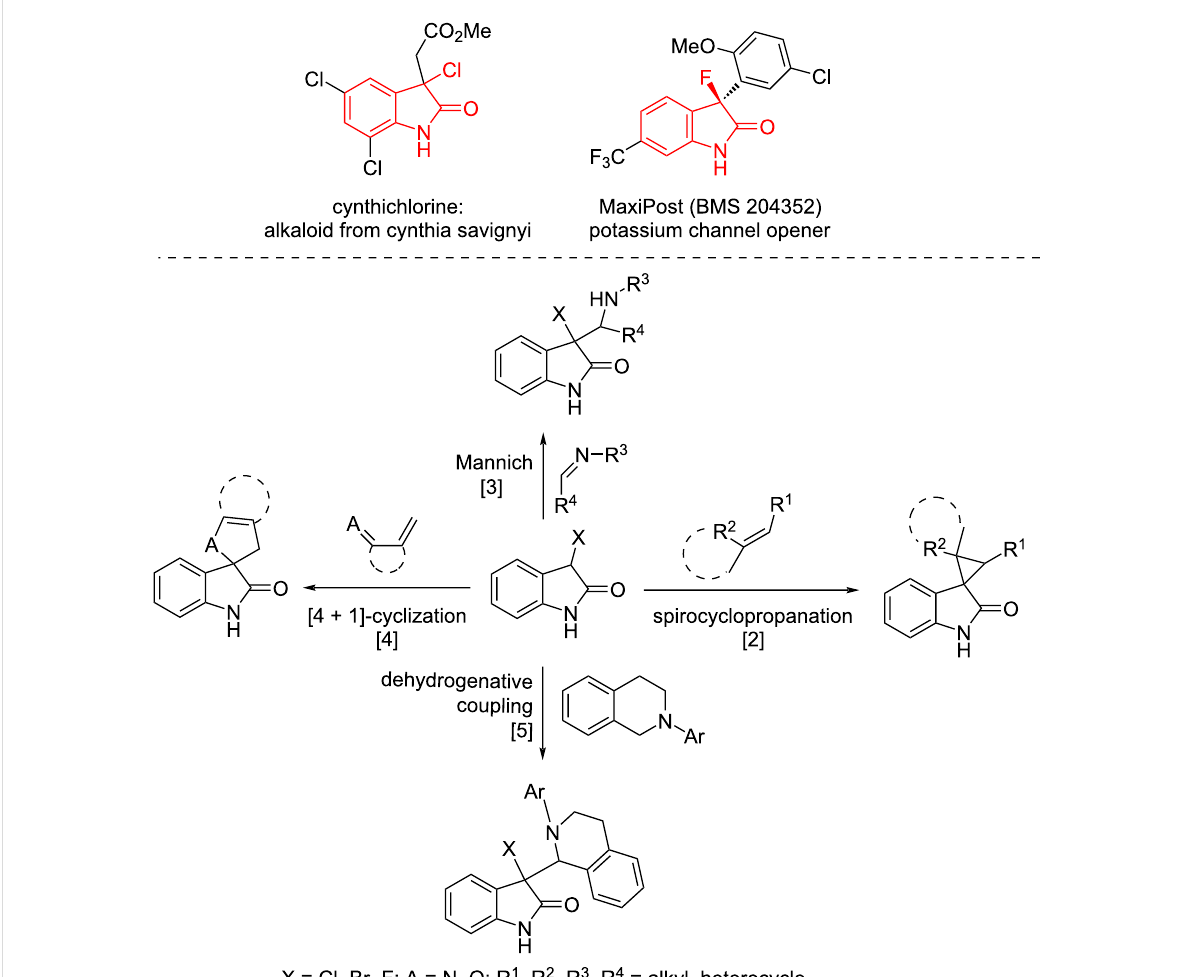
Figure 1: Representation of bioactive molecules and applications.